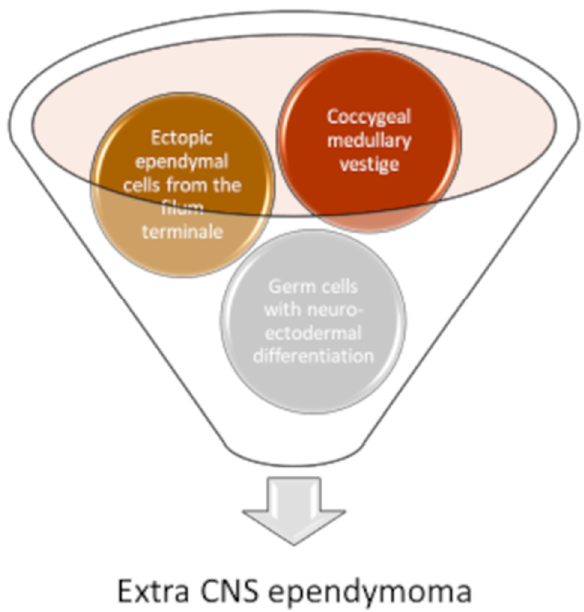
Figure 2. There are three hypotheses regarding the origin of the extra CNS ependymomas: From the coccygeal medullary vestige (an ependymal lined cavity forming from the remnants of the caudal portion of neural tube); from ectopic ependymal cells originating from the filum terminale; from primordial germ cells with neuroectodermal differentiation.